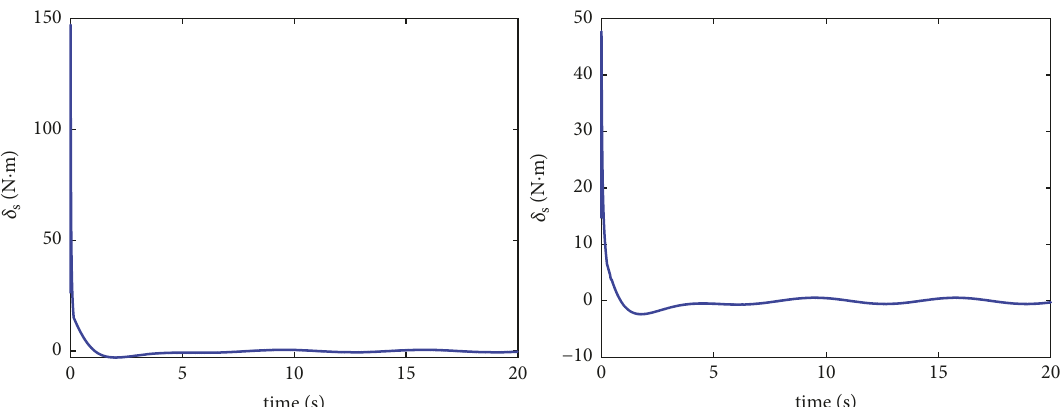
Figure 5: The complete control law 𝛿 𝑠 in the entire simulation interval.